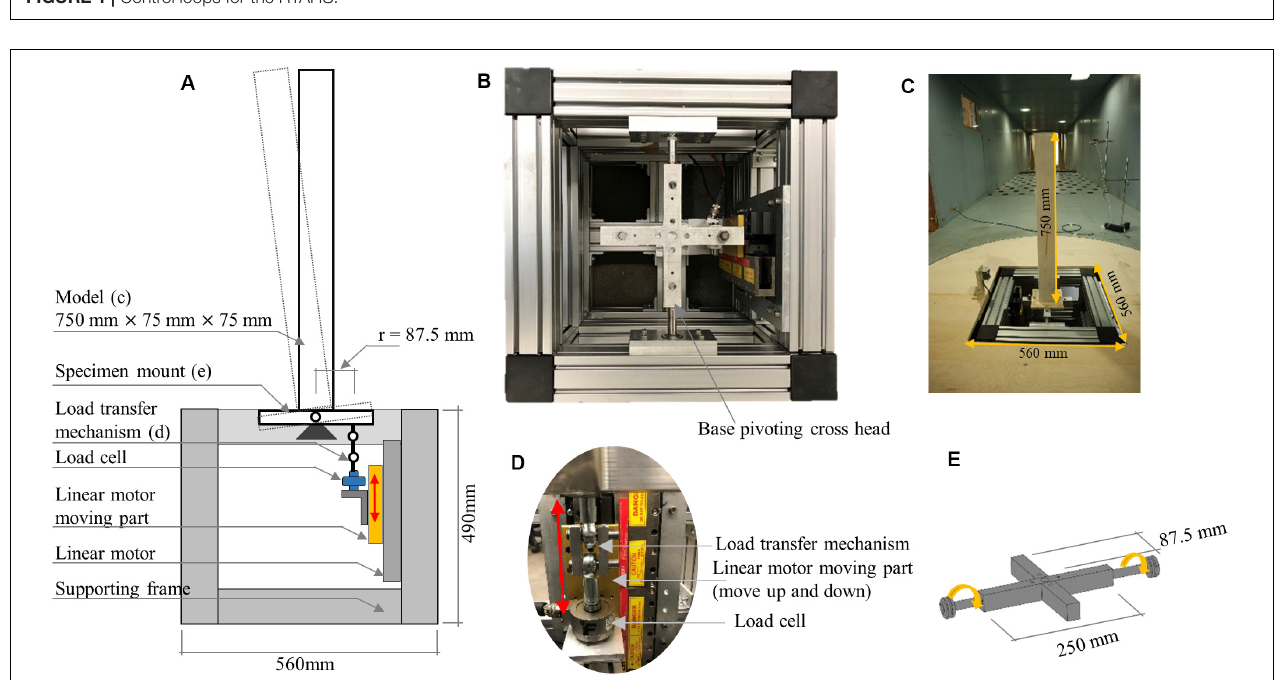
FIGURE 2 | Experimental setup. (A) Schematic configuration of the developed system, (B) plan, (C) physical substructure in wind tunnel, (D) side view of the linear motor moving part, and (E) details of the